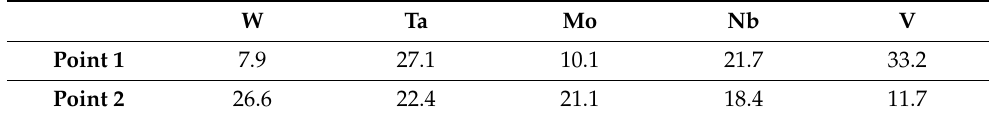
Table 8. Local chemical compositions (at. %) by EDS analysis, related to Figure